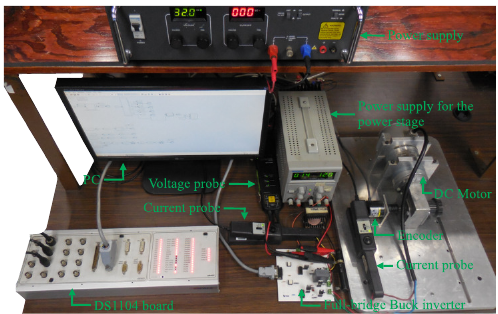
Figure 9. Experimental prototype of the full-bridge Buck inverter–DC motor